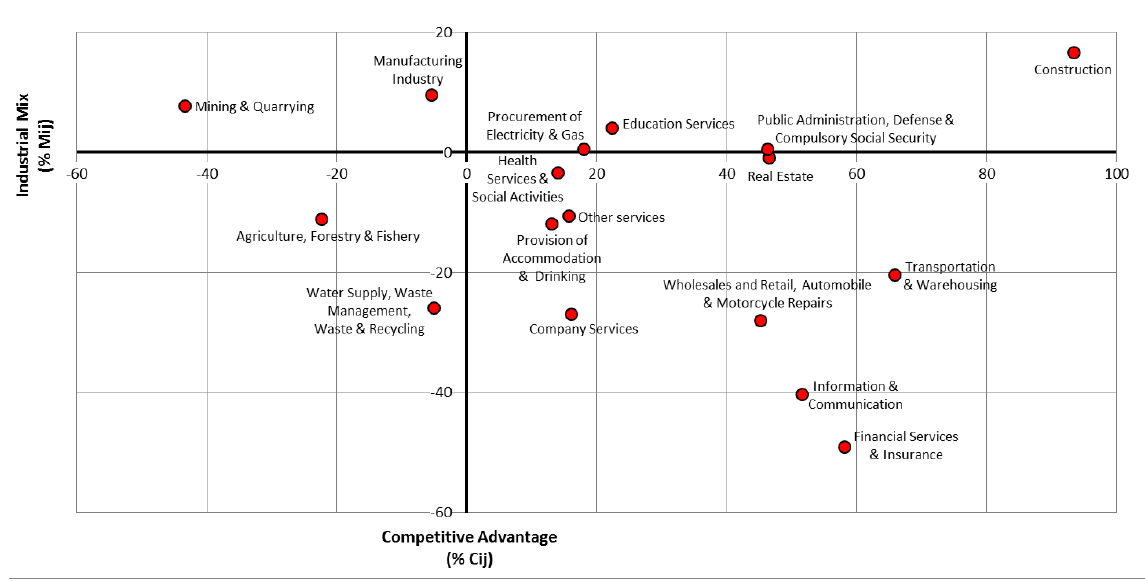
Figure 3: Profil of Sectoral Economic Growth of Teluk Bintuni